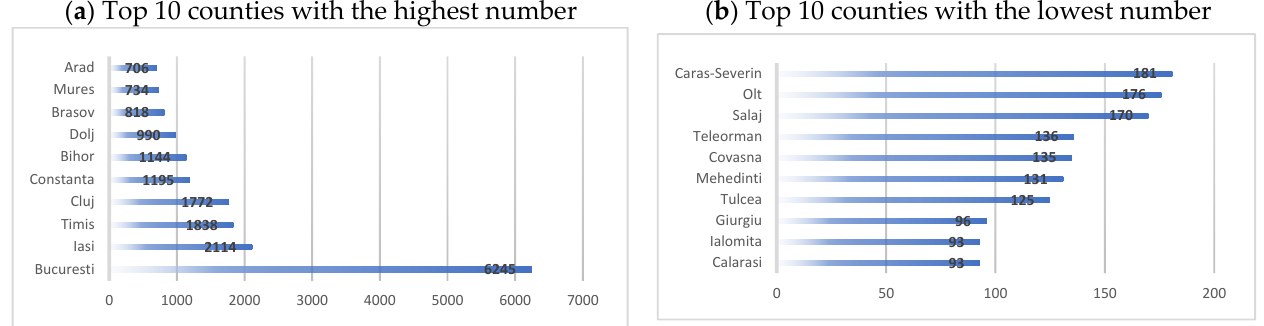
Figure 3. Number of dentists registered by The Romanian College of Dentists. Source: computed by the authors based on the RCD database [28].